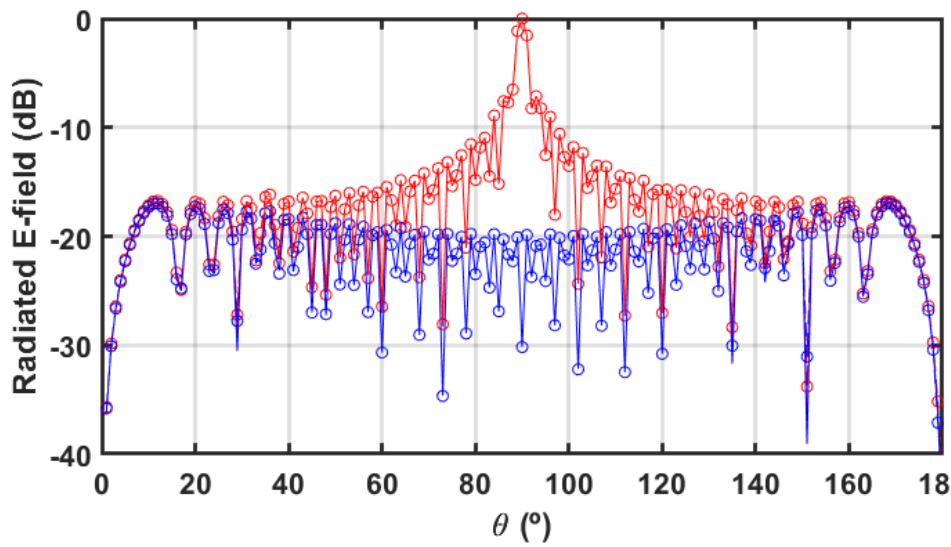
Figure 16. Radiated E-fields. Case Table 2-(1) with 48 antennas step = 0.12 m: (---) Horizontal polarization (E φ ). (-o-) Horizontal polarization (E φ ) with helix. (---) E θ without helix. (-o-) E θ with helix.